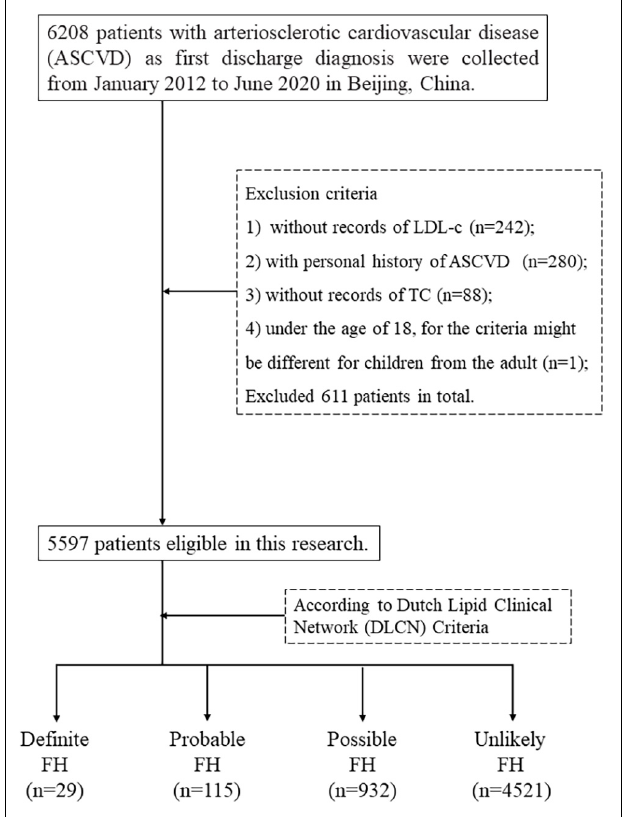
FIGURE 1 | The exclusion process of first-ever ASCVD